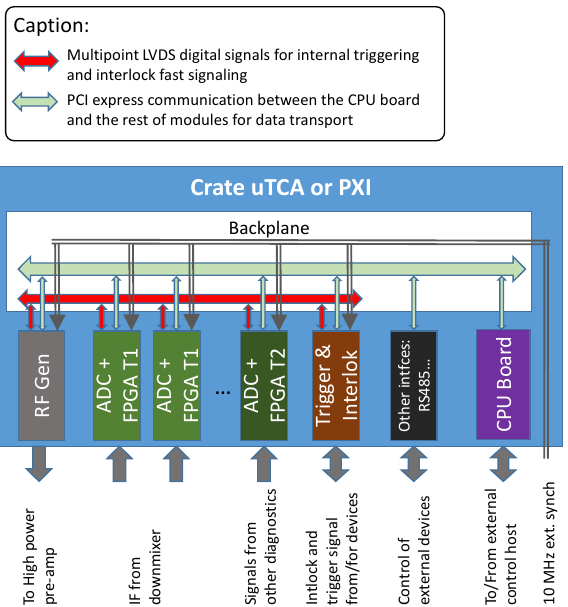
Figure 11. Conceptual diagram of the embedded modular system with the fundamental elements to carry out the control and acquisition of the LLRF system.